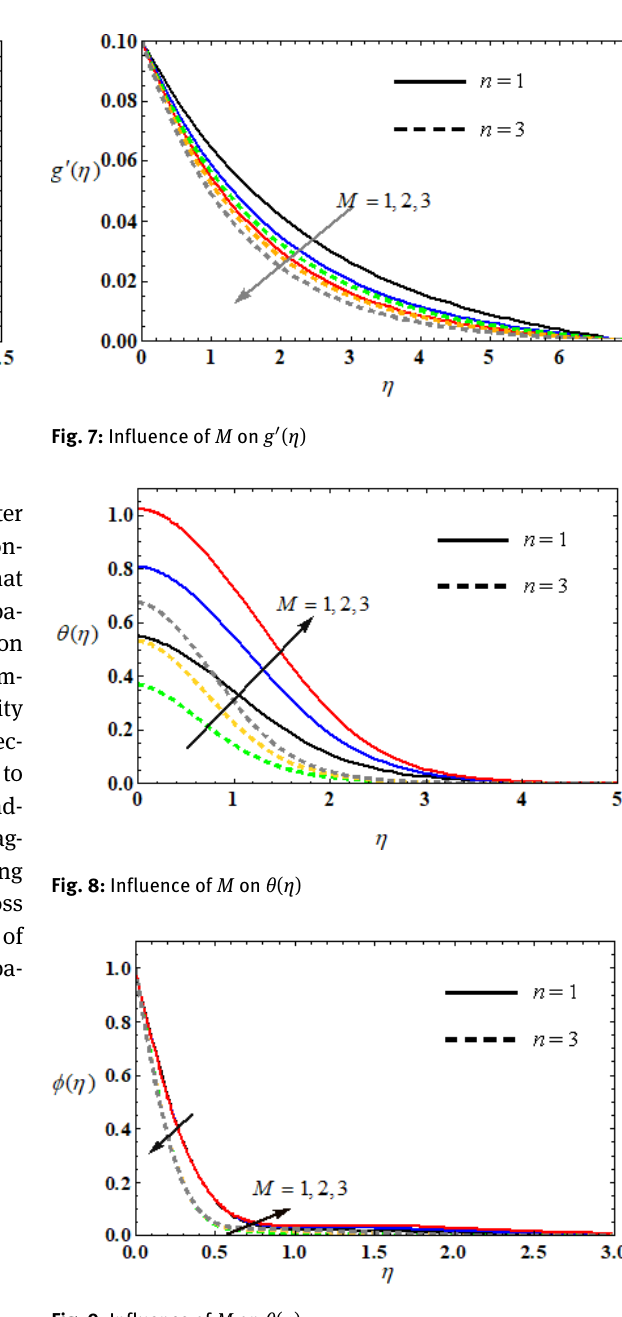
causestoincreasethepressureonthefluidflow,duetothis both the temperature and concentration decreases (Fig- ures 12–13). It is obvious to see that increase in the radi- ation parameter results in decreasing the temperature of the fluid near the surface and increasing the temperature (Figure 14) for away from the surface within the boundary layer. It is clear from these Figures 15 and 16 that both the temperature and concentration of the fluid increases